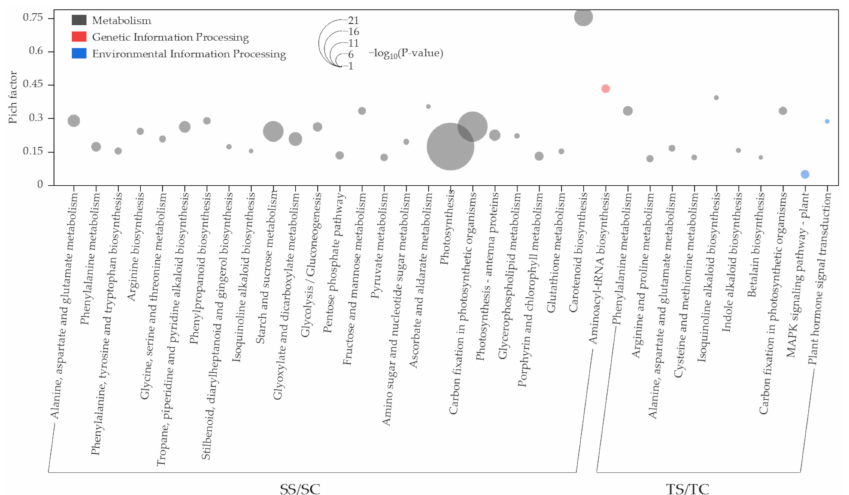
Figure 2. Enrichment analysis of